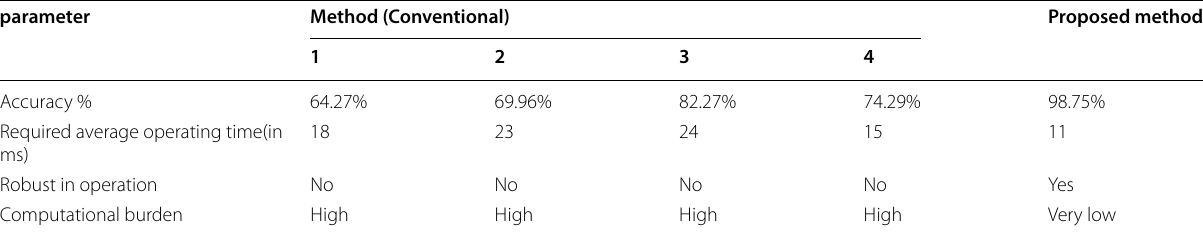
Table 11 Comparison of proposed with conventional methods in various factors